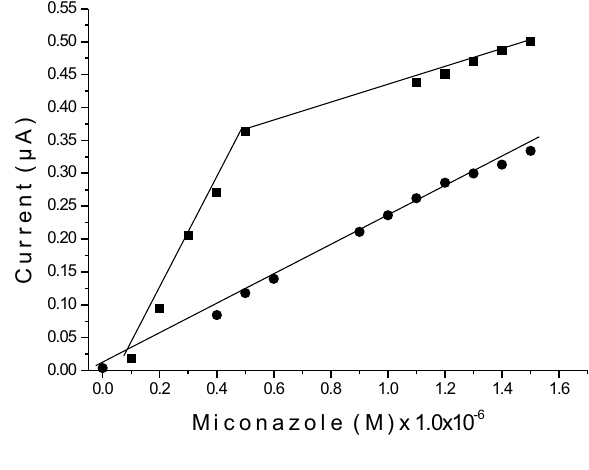
Fig. 5 – Calibration curves obtained for miconazole in B-R buffer pH 8.0. E ac = 0V, ν = 100mV s -1 , using accumulation time of 30s ( • ) and 100s ( (cid:1) )